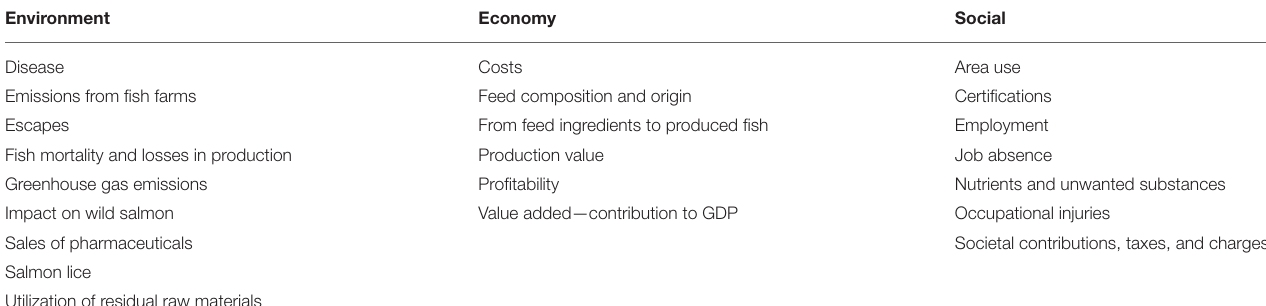
TABLE 2 | Themes in the portal, as of March